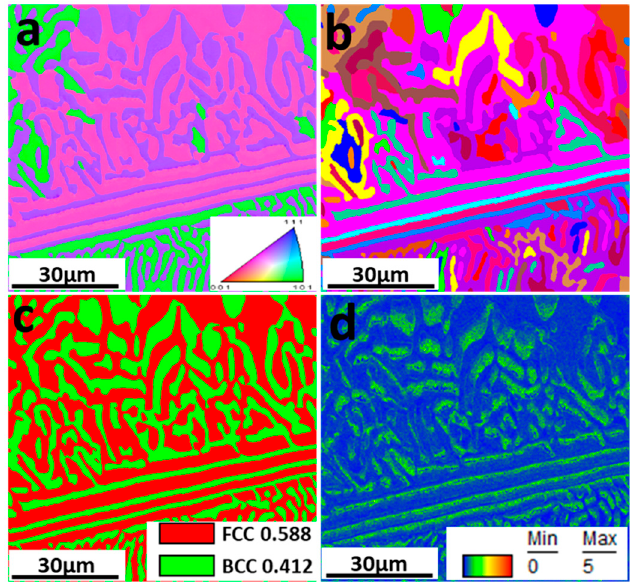
Figure 2. EBSD results of AlCoCrFeNi 2.1 : ( a ) IPF map; ( b ) Grain map; ( c ) Phase map; ( d ) KAM map.